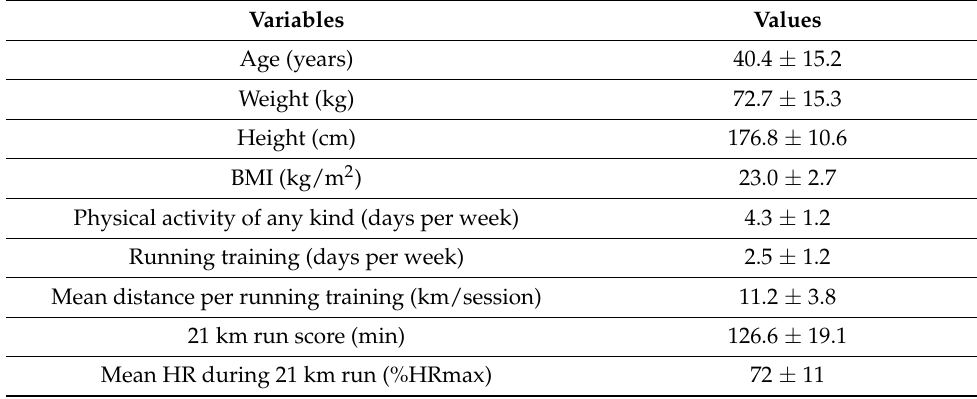
Table 1. Baseline characteristics of recreational runners participating in the study (n =